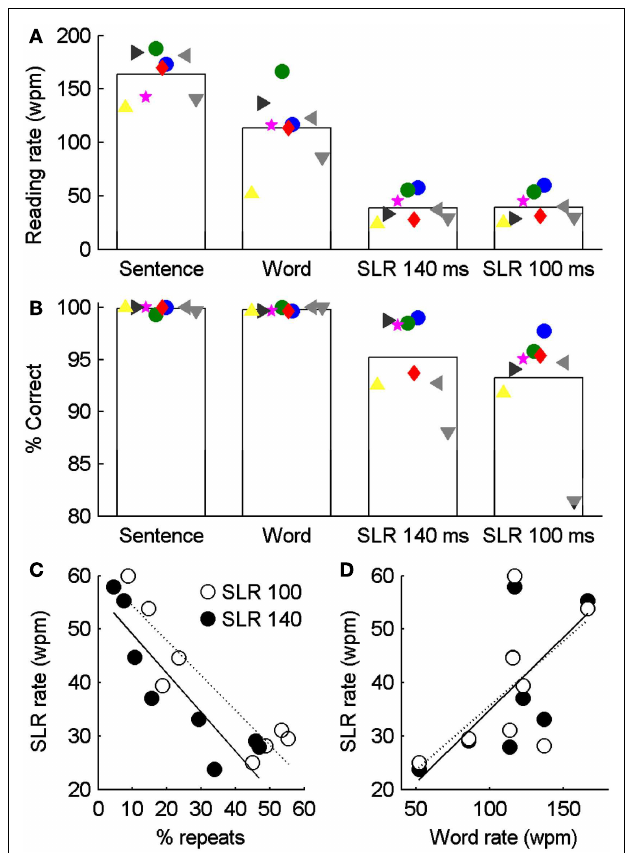
FIGURE 7 | Comparison of reading accuracy and rate for whole paragraphs presented as complete sentences, single words, or individual letters (SLR with t Letter 140 or 100ms). Bar graphs show mean word identification accuracy (A) and reading rate (B) . Large green and blue spots correspond to data from subjects S4 and S5 in earlier figures, who had extensive training from the previous tasks before completing the paragraph task. Other data points correspond to naïve subjects who had no previous exposure to single letter reading. Reading rate in the SLR conditions was significantly negatively correlated with the proportion of words that were repeatedly viewed [ (C) : r 100 =− 0.91, p 100 < 0.01; r 140 =− 0.89, p 140 < 0.01], but was not significantly correlated with the reading rate of whole sentences [ (D) : r 100 = 0.43, p 100 = 0.29; r 140 = 0.48, p 140 =